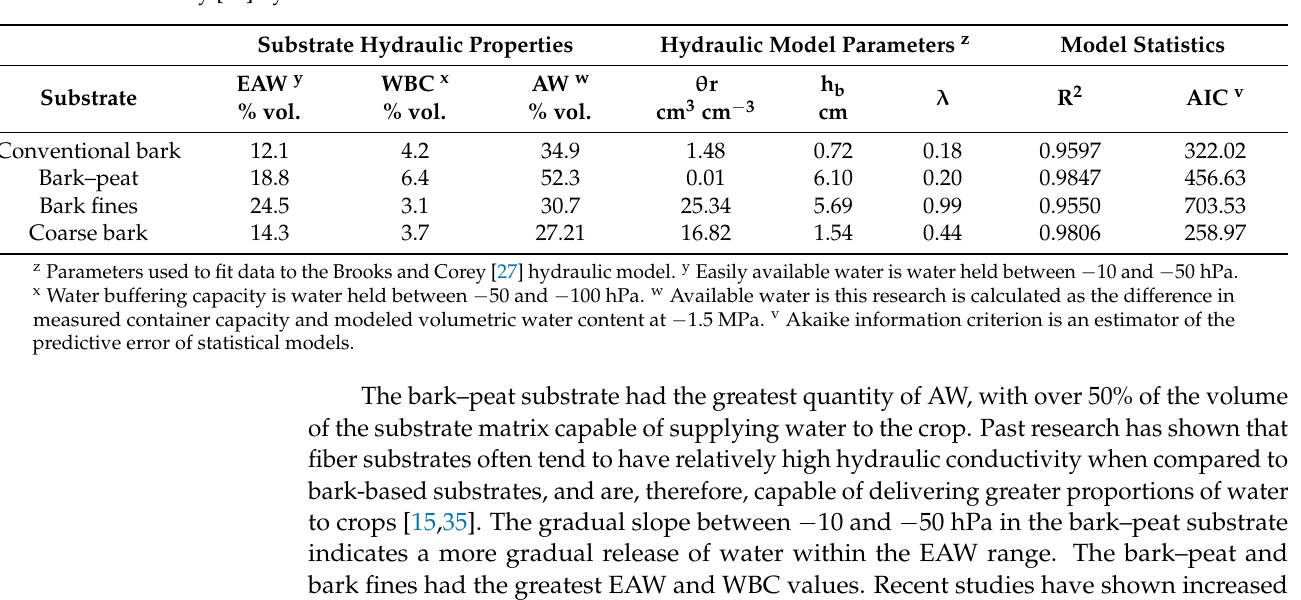
Figure 1. Moisture characteristic curves for the four components used in the control and stratified substrates as determined by evaporative method. The relationship between substrate water potential and volumetric water content measures (circles) were used to fit to a Brooks and Corey [27] hydraulic model (lines). Table 2. Hydraulic properties and parameters of four bark-based soilless substrates engineered through particle fractionation or amendment with fibrous materials. Properties and parameters were derived from moisture characteristic curves fit to the Brooks and Corey [27] hydraulic